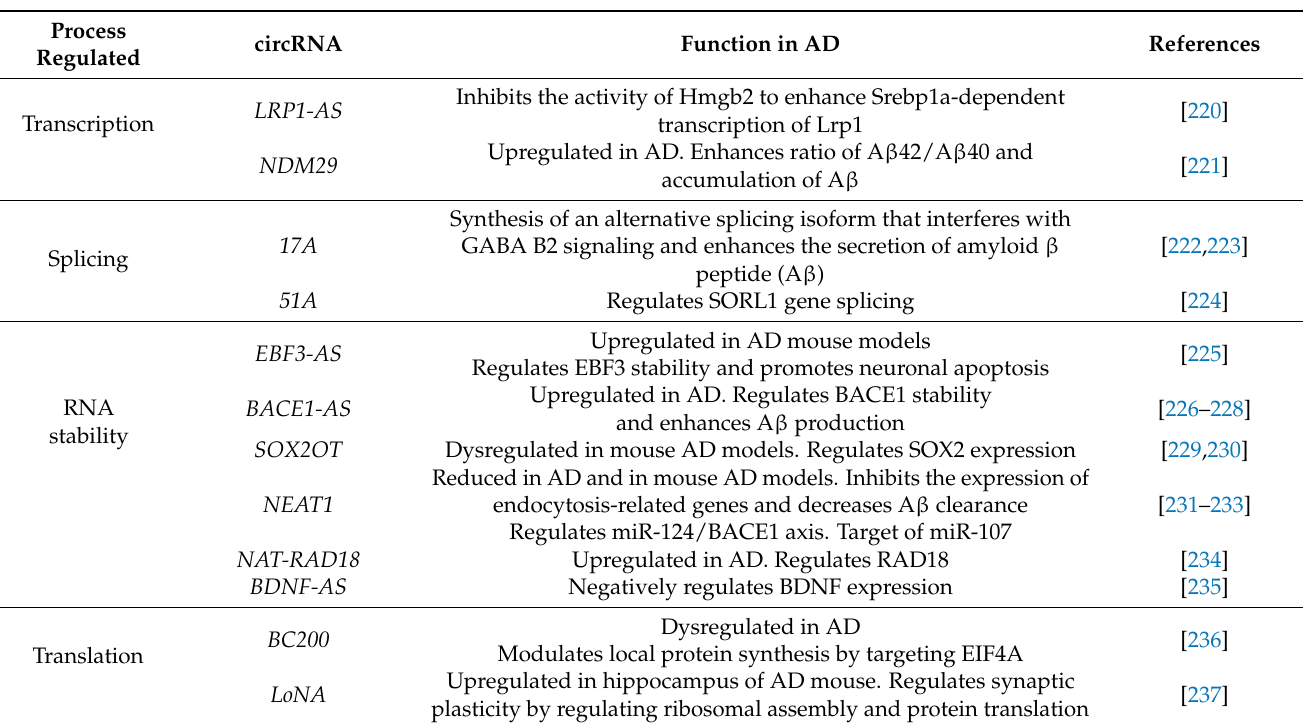
Table 3. Functional lncRNAs in